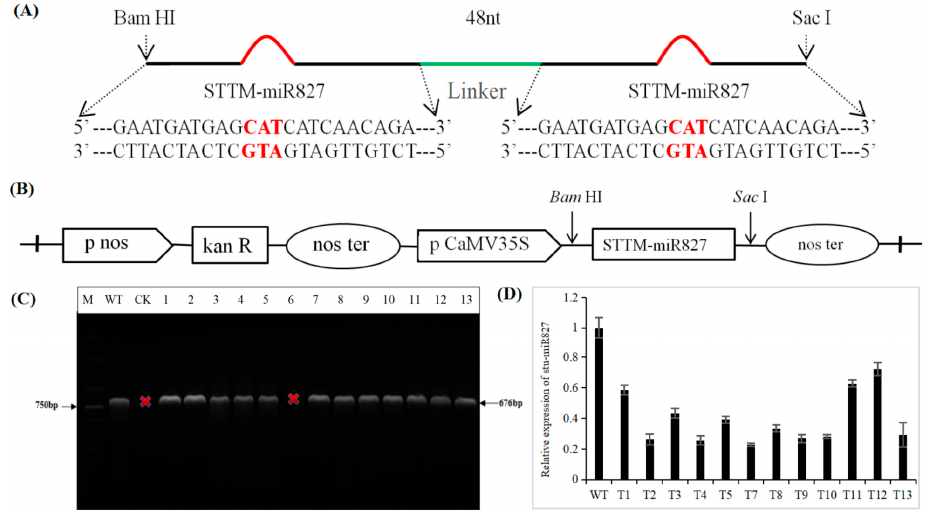
Figure 2. Construction of STTM-miR827-5p vector and potato transformation. ( A ) The short tandem target mimic (STTM) construct used for silencing stu-miR827-5p. ( B ) The STTM-miR827-5p fragment was cloned into the pBI121 binary vector under the CaMV 35S promoter. ( C ) PCR detection of the NPTII gene in transgenic plants. Note: M: DL2000 marker; WT: wildtype plants transformed with the empty vector (pBI121); CK: wildtype plants; 1–13: transformed plant lines containing the STTM-miR827-5p fragment. ( D ) Expression levels of miR827a-5p in WT and transgenic